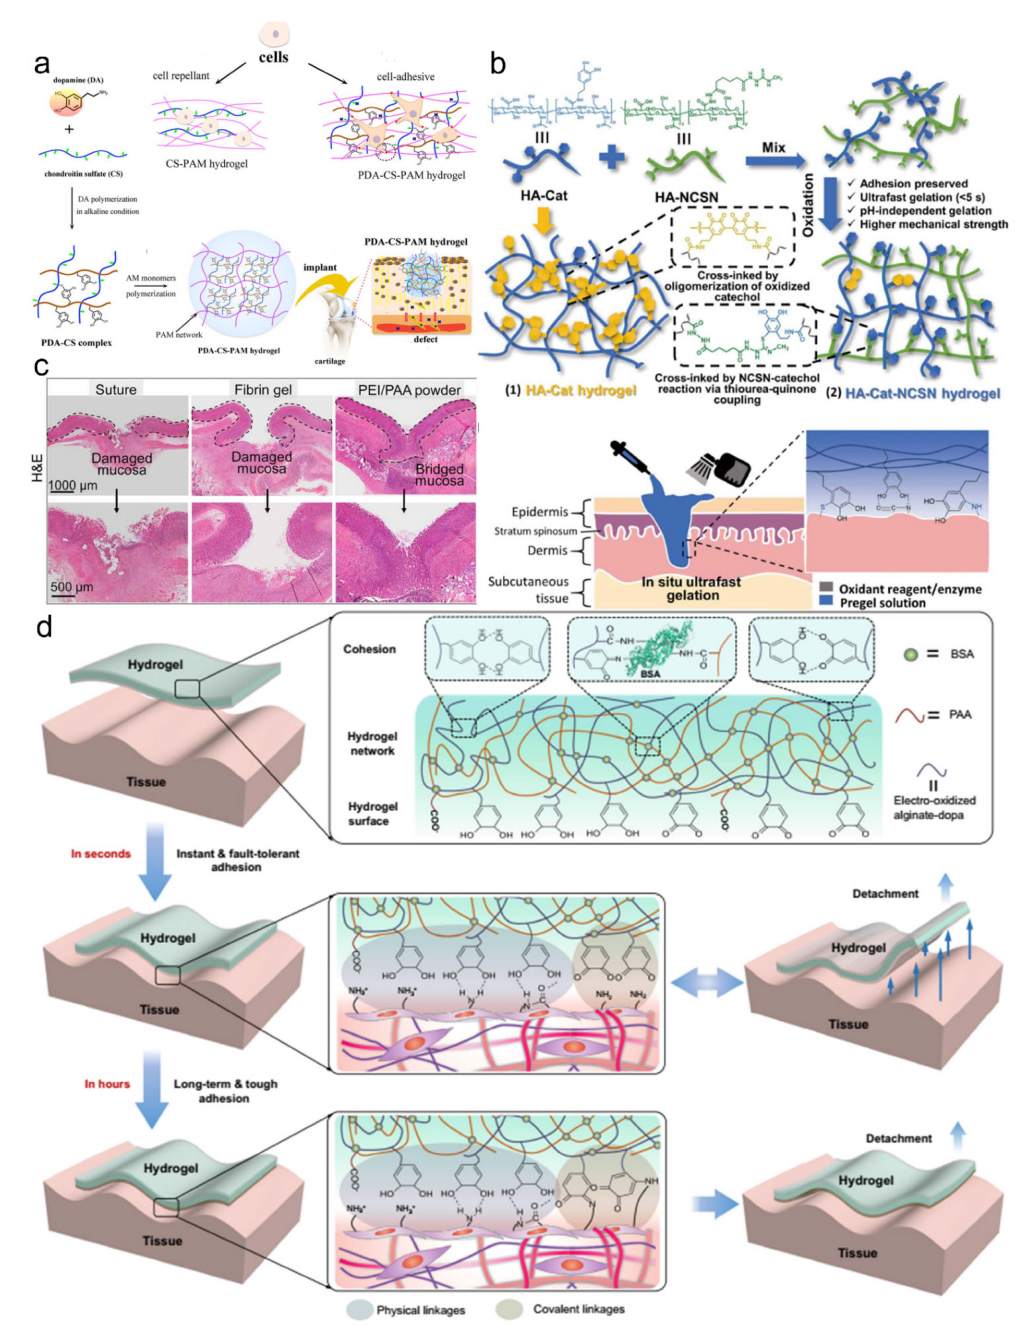
Figure 7. ( a ) Chondrocyte growth and cartilage regeneration were promoted by a growth-factor-free polydopamine-chondroitin sulfate-polyacrylamide hydrogel. Reproduced with permission [87]. Copyright 2018, American Chemical Society. ( b ) Schematic illustration of the fabrication process and mechanisms for the adhesion. Reproduced with permission [88]. Copyright 2020, American Association for the Advancement of Science. ( c ) H&E staining of the gastric wounds treated by different bioadhesives was compared. ( d ) Schematic illustration of the adhesion mechanism on the tissue